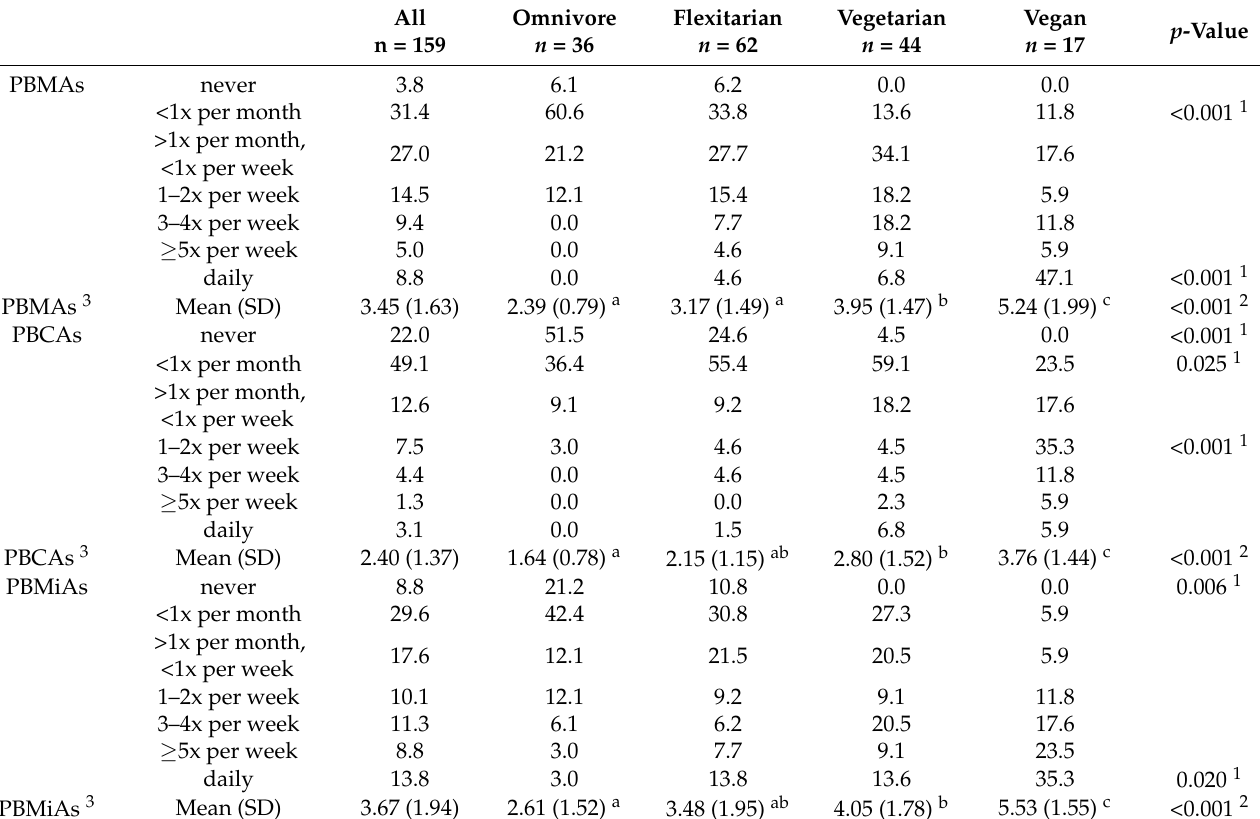
a–c Values with the same superscript letter indicate statistically significant differences between nutritional styles based on the Kruskal–Wallis rank test, and when differences existed, they were determined using the